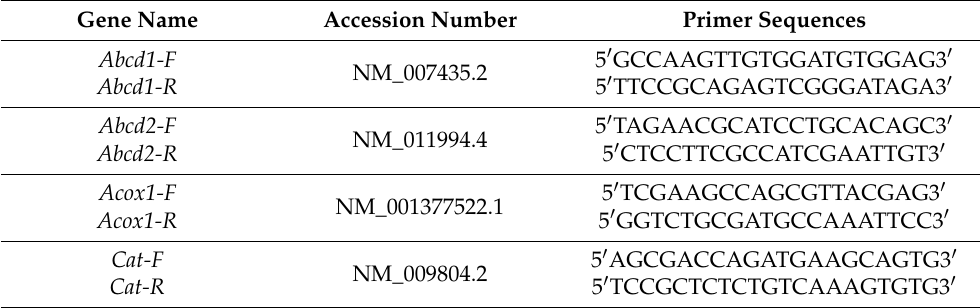
Table 1. Sequences of the primers used for